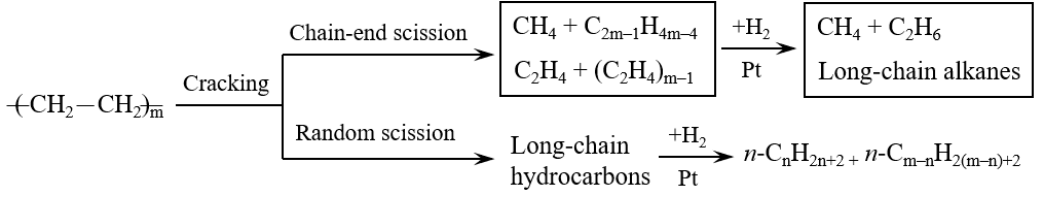
Figure 6. Scission types of carbon chain in the hydrocracking of polyethylene.